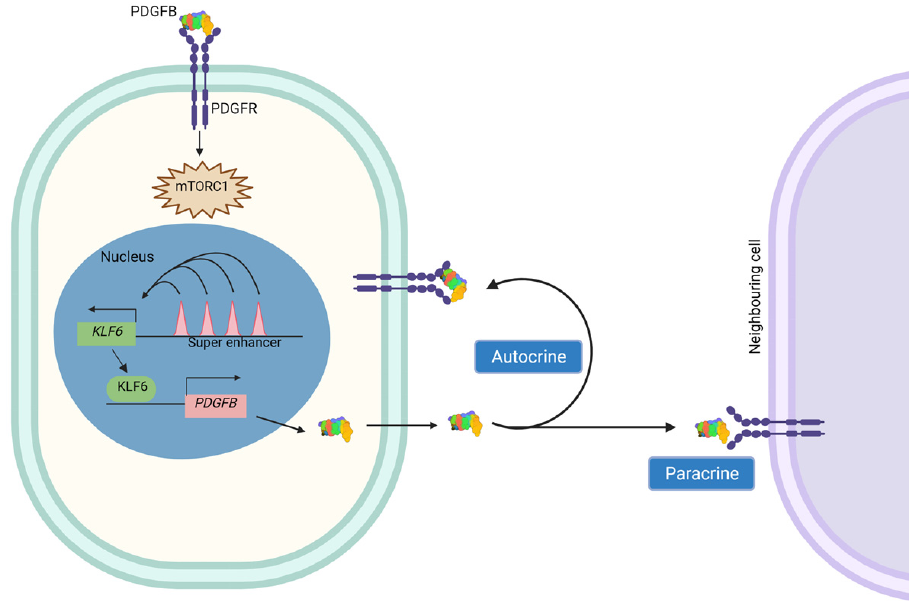
Figure 6. Summary—The mode of mTORC1 signaling pathway stimulation in ccRCC by cancer- derived PDGFB.